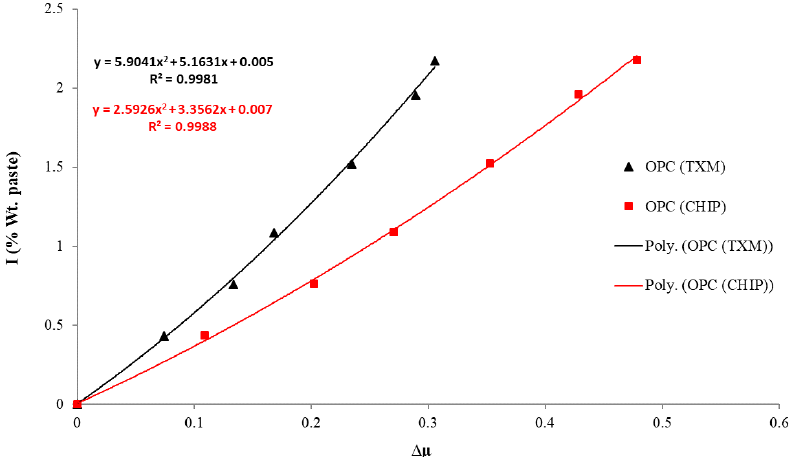
Figure A4. Calibration curve for paste (w/cm = 0.4) that was used to calculate concentrations in concrete samples.